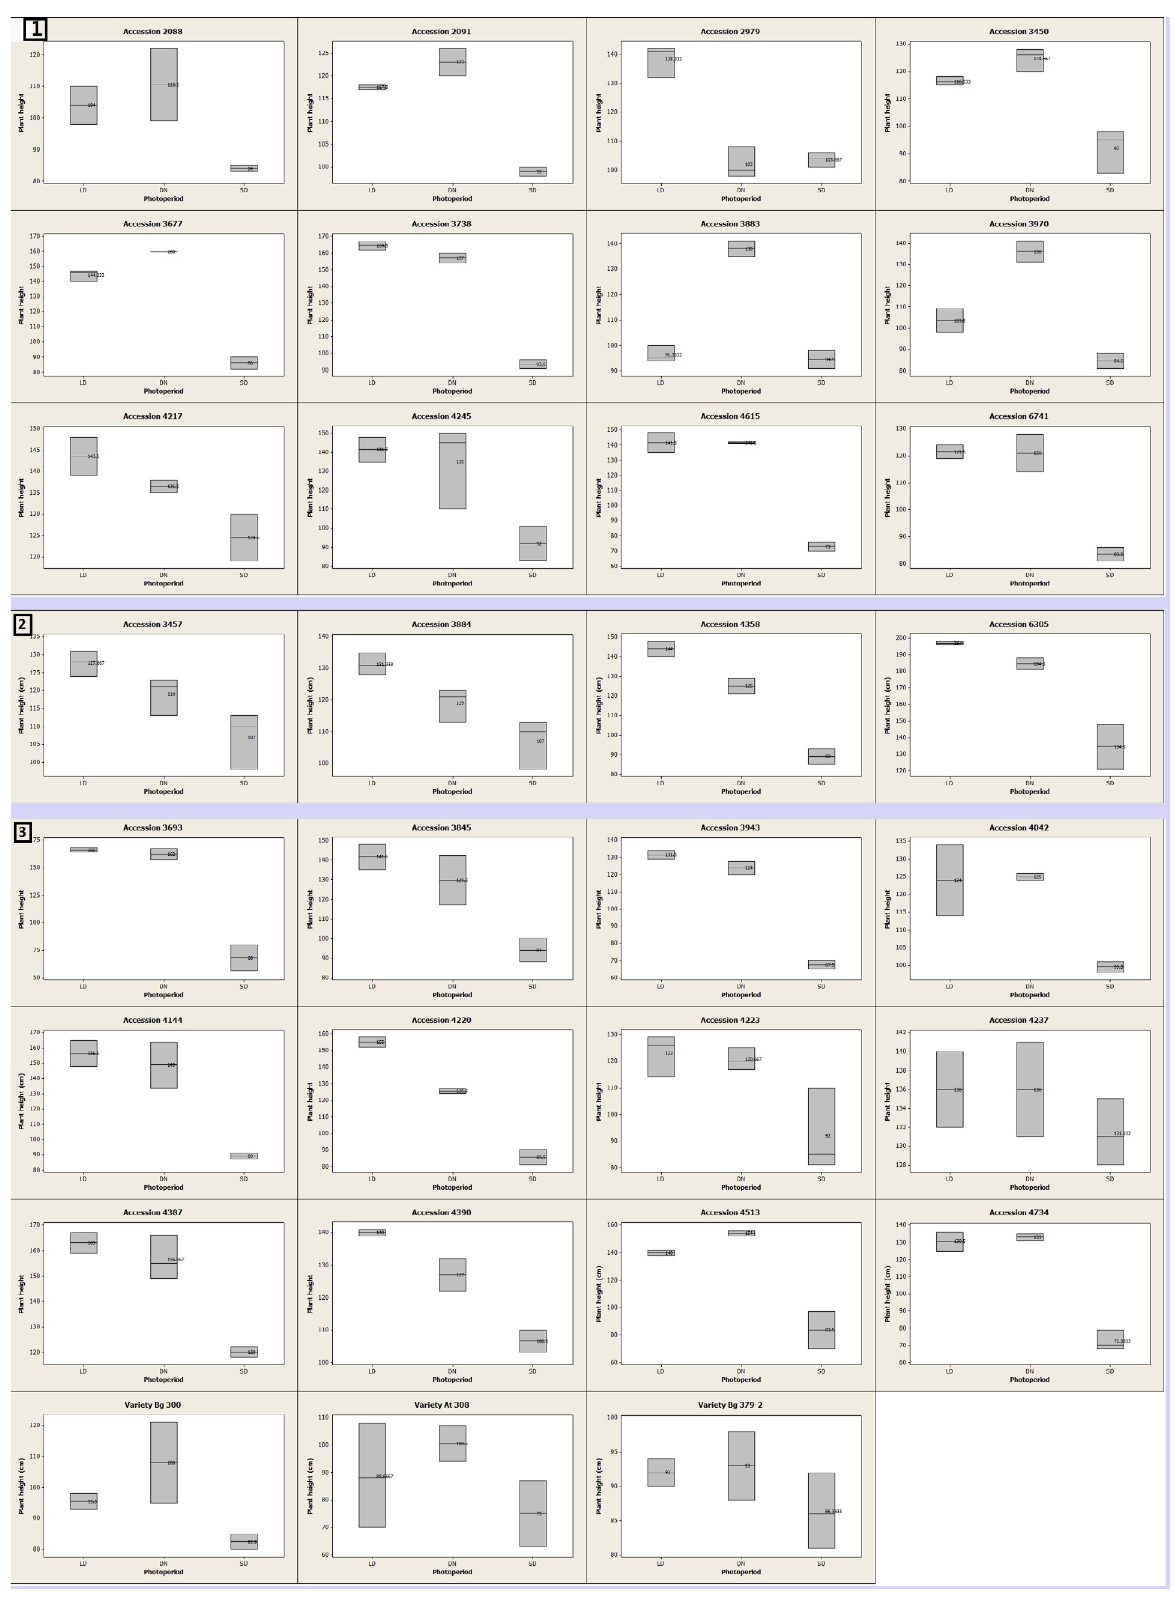
Figure 3: Effect of photoperiod on plant height variation among Sri Lankan very early maturing rice accessions: 1) that flowered early under LD condition; 2) that flowered early under DN condition; 3) that flowered early under SD